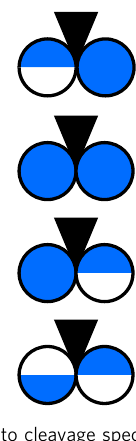
Fig. 1 Chitosanase classi fi cation according to cleavage speci fi city with the respective origins for example enzymes. A-units are represented in white, and D-units are represented in blue. For a position, in which either an A-unit or a D-unit can be present, the circle is half-white and half-blue. The point of cleavage is indicated by a black inverted